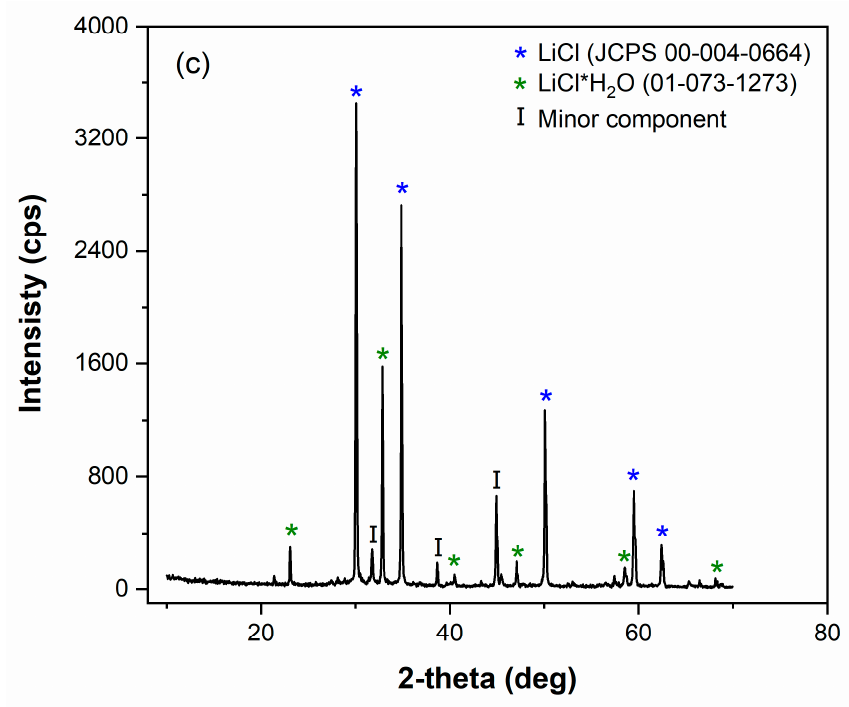
Figure 6. XRD patterns of the SP samples from the isothermal experiment at 700 °C for the BM/CaCl 2 /CB system: ( a ) VBM-1, ( b ) VBM-2, and ( c ) SBM.